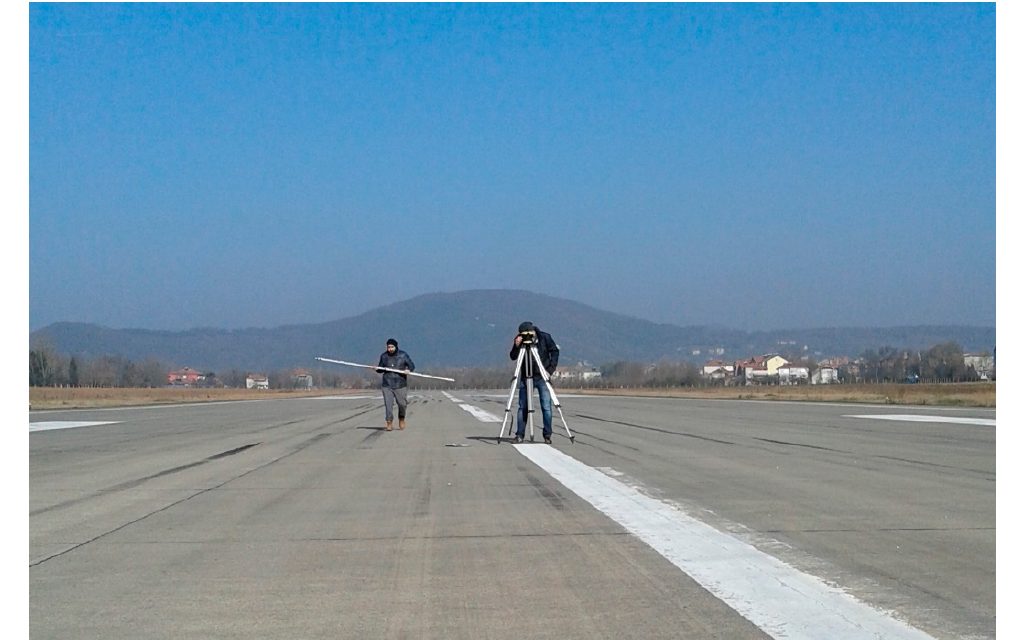
Figure 3. Leveling of the runway in progress. Photo: K. Becek.